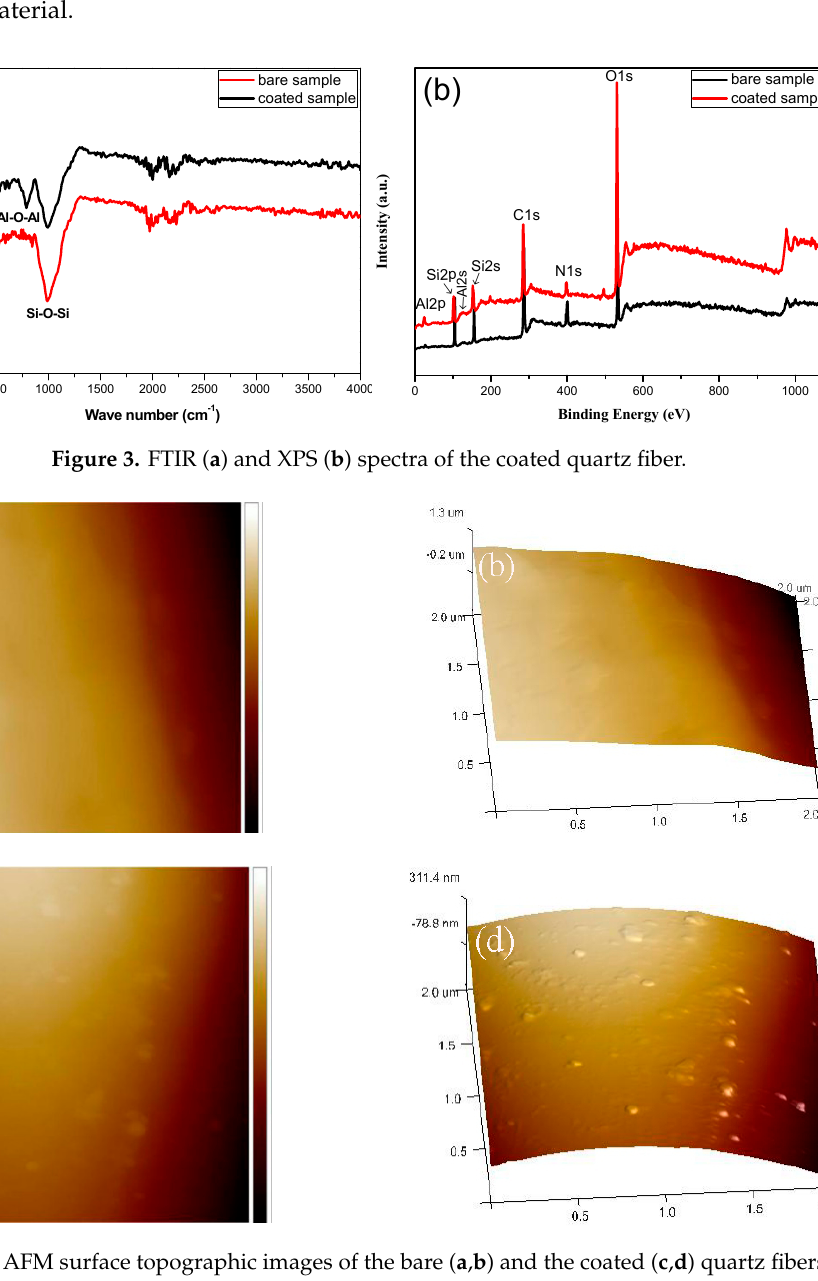
Figure 4. AFM surface topographic images of the bare ( a , b ) and the coated ( c , d ) quartz fibers.